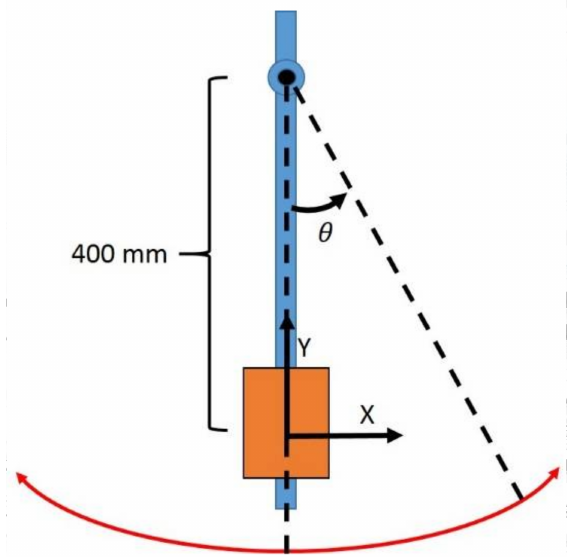
Figure 4. Diagram of numerically simulated pendulum setup. Note that the Z axis is perpendicular to the XY plane as defined by the right-hand rule. The orange block represents the inertial